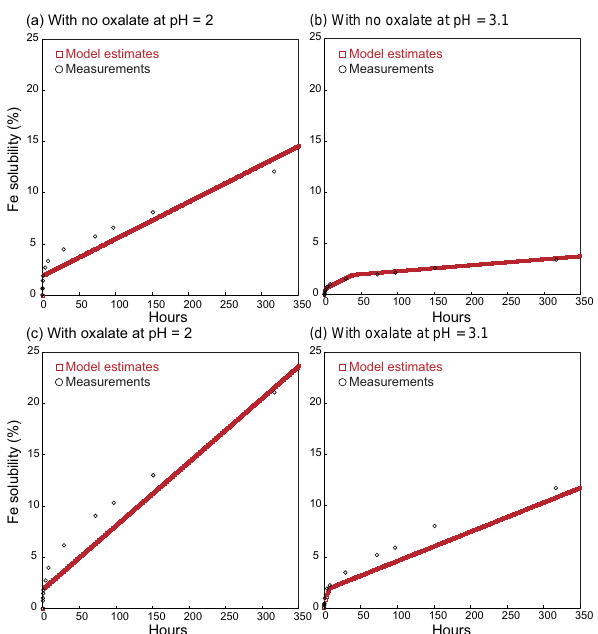
Figure 3. Comparison of Fe solubility in solution (%) predicted using Eq. (1) with the measured Fe dissolution rates at pH = 2, 0.005M H 2 SO 4 , and dust / solution of (a) 60mgL − 1 , (b) 1gL − 1 , (c) 10gL − 1 , and (d) 50gL − 1 . The red squares are calculated using Eq. (1) from the equilibrium constant (mol 2 kg − 2 ) used in this study at each hour. The black circles are our measured data. The frac- tion of total dissolved Fe present as Fe(III) is prescribed at pH = 2 (0.2) in this calculation to emulate the experimental conditions, while the photochemical redox cycling between Fe(III) and Fe(II) in solution is explicitly simulated in our global model (Lin et al., 2014). The large fraction of Fe(II) in solution under the dark condi- tions is likely associated with the Fe dissolution of Fe(II)-containing solids (Cwiertny et al., 2008). The initial fraction of Fe speciation is not critical in estimating the Fe redox speciation in aerosol water, because Fe(II) is quickly oxidized to Fe(III) in oxygenated water (Deguillaume et al.,